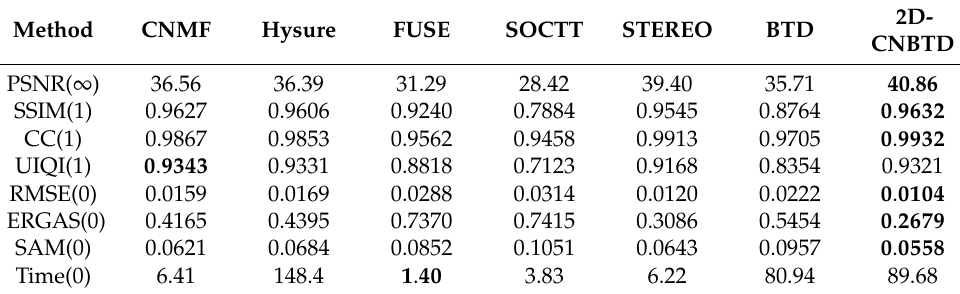
Table 2. Performance for Pavia